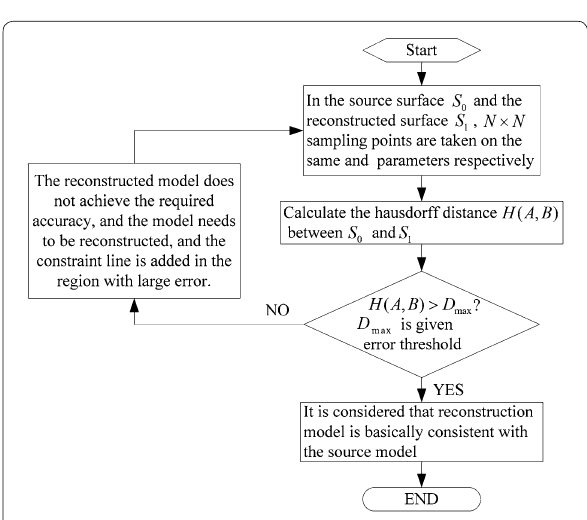
Figure 11 Discrimination process of the reconstruction model and source model matching